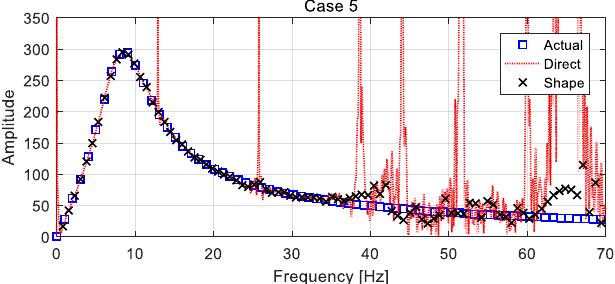
Figure 16. Comparison of the amplitudes of the vehicle acceleration FRF along DOF u 1 in Case 5.